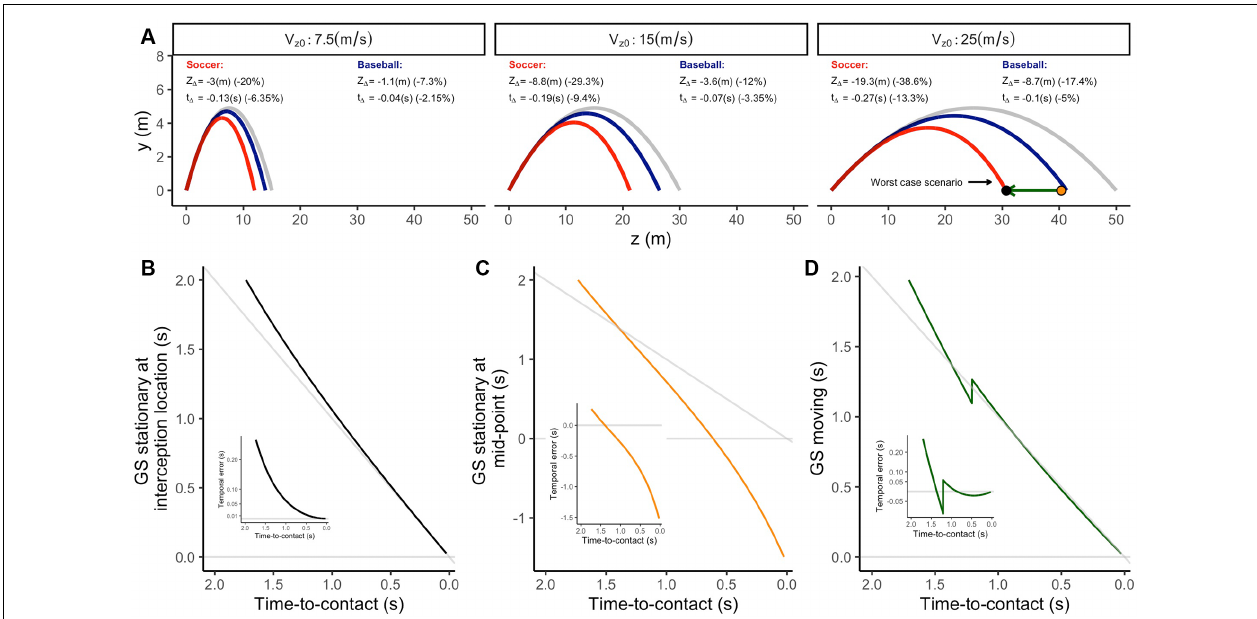
FIGURE 9 | (A) Lateral view of different parabolic trajectories under gravity (gray lines) and gravity + air drag conditions for two different balls (red: soccer ball; blue: baseballs) and three initial approaching speeds (different panels). The figure annotates the difference in distance traveled ( Z ∆ ) and flight duration ( t ∆ ) compared to a trajectory only considering gravity. The black and orange dots in the third panel indicate the position of the corresponding simulated observer in panels (B) or (C,D) , respectively. The green arrow indicates the displacement simulated in panel (D) . Panels (B–D) indicate the predicted TTC using the GS model for different simulated observers in the worst-case scenario simulated. Insets depict the corresponding temporal errors using the predictions of the GS